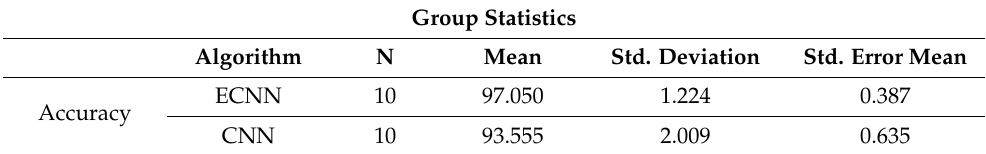
Table 4. Group statistics parameter comparison with accuracy for ECNN and CNN